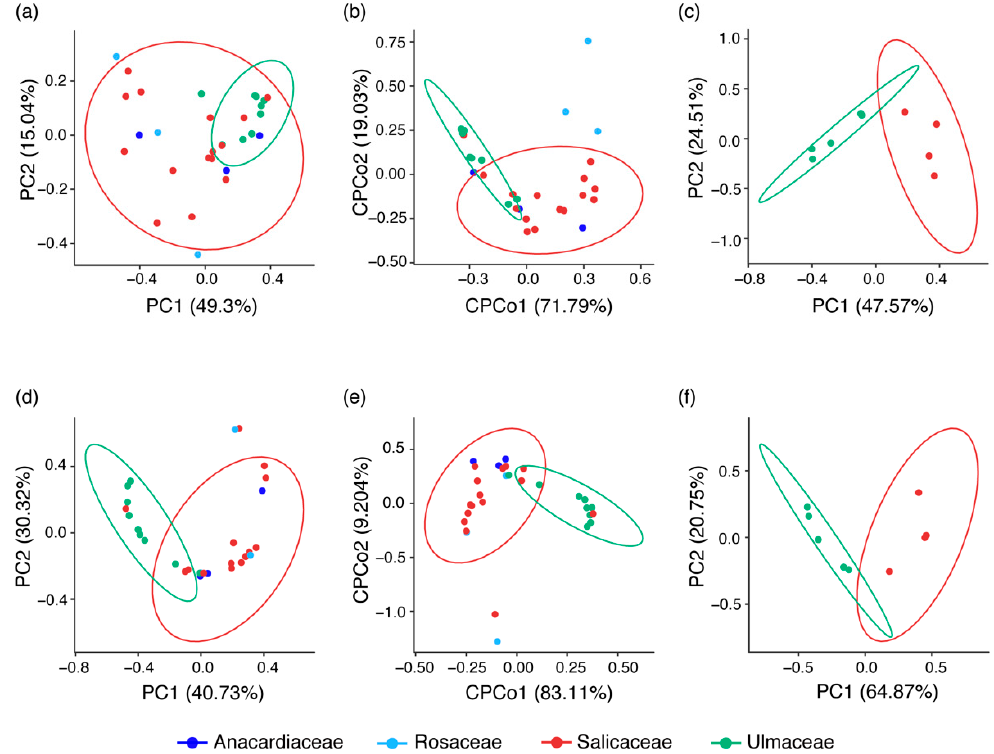
Figure 2. PCoA plot illustrating the separation of all samples from four host plant groups (a and d) and species distributing in the same location from two host plant groups (c and f) based on differences in bacterial community structure (a and c) and facultative symbiont community structure (d and f) ; CPCoA plot illustrating the separation of samples from four host plant groups based on differences in bacterial community structure (20.0% of the total variance and p = 0.003) (b) and facultative symbiont community structure (21.5% of the total variance and p = 0.001) (e) . Colours correspond to different plant families, as shown in the legend. Ellipses cover 95% of the data for each plant families.